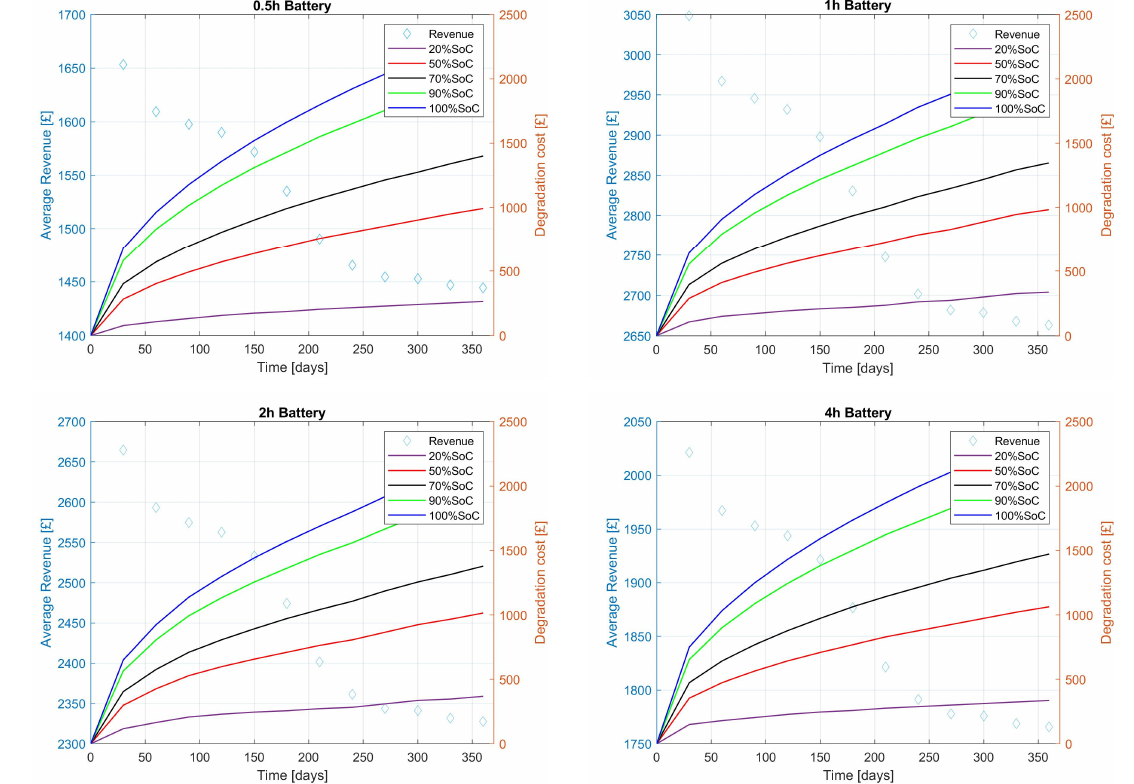
Figure 8. Revenue and degradation costs for four de-rated batteries (0.5 h–4 h) for a one-year capacity market contract at different temperatures and at 100% state of charge. Table 2. Calendar and cycle degradation model accuracy comparisons for different temperatures.